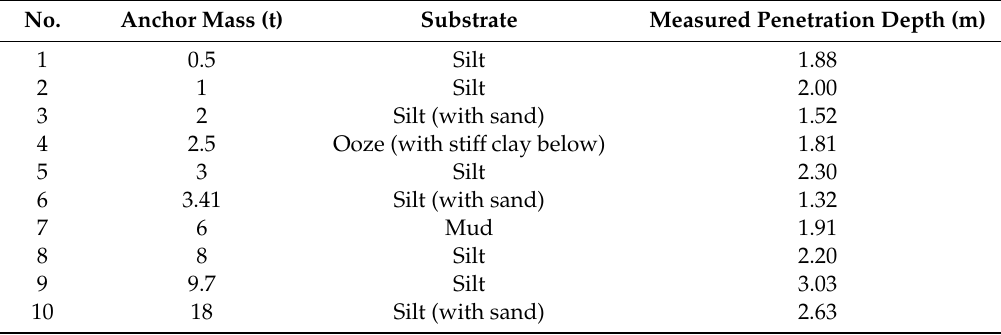
Table 3. Penetration depth in clay substrate from anchoring experiments.